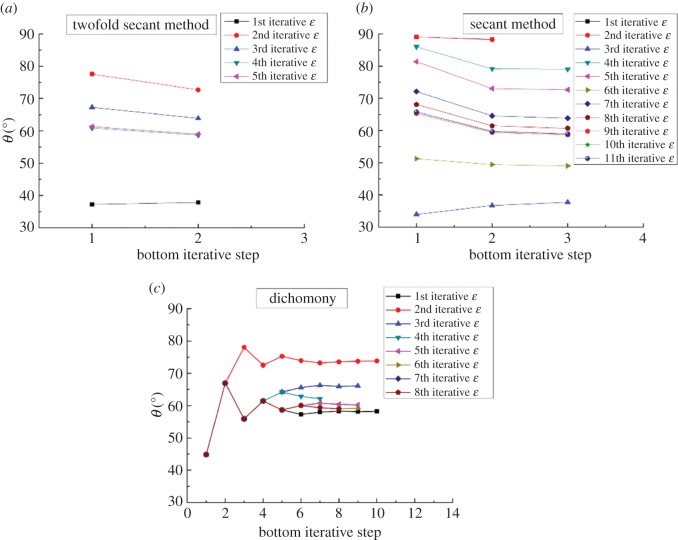
(a–c) Convergence for the attitude angle, Lb = 0.1 m.